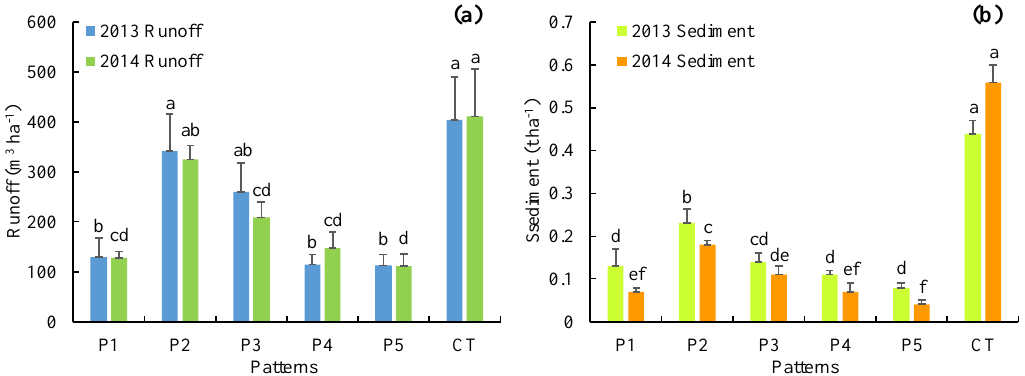
Figure 5. Runo ff and sediment for di ff erent crop-mulberry planting patterns. The same letters above Figure 5. Runoff and sediment for different crop-mulberry planting patterns. the bars indicate no significant di ff erence and di ff erent letters indicate significant di ff erences between these groups (p <